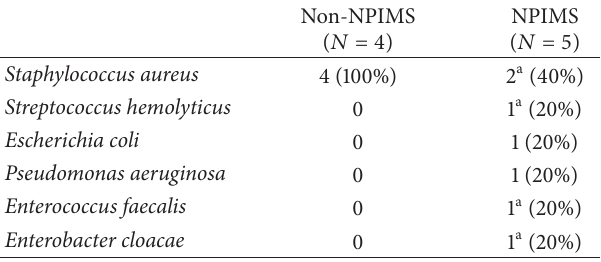
Table 5: Microbiological cultures of groin wound